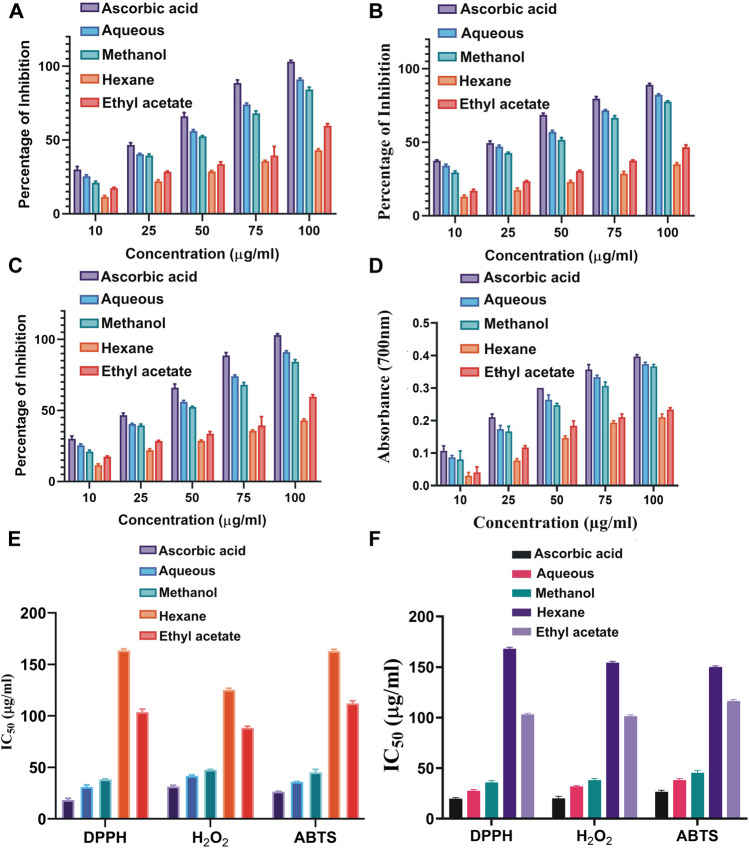
Antioxidant activity of different polar and nonpolar solvent extracts of S. monoica at different concentrations (10–100 μg/ml). (A) 2-2-Diphenyl-1-picryl-hydrazyl (DPPH) free radical scavenging activity, (B) ABTS radical-scavenging ability, (C) H2O2 radical scavenging activity, (D) total reductive capability (E) IC50 values of antioxidant activities of the leaves, and (F) IC50 values of antioxidant activities of the RS extracts. The bar diagrams represent the mean ± SD (n = 3, p < 0.05) for all tested dosages.